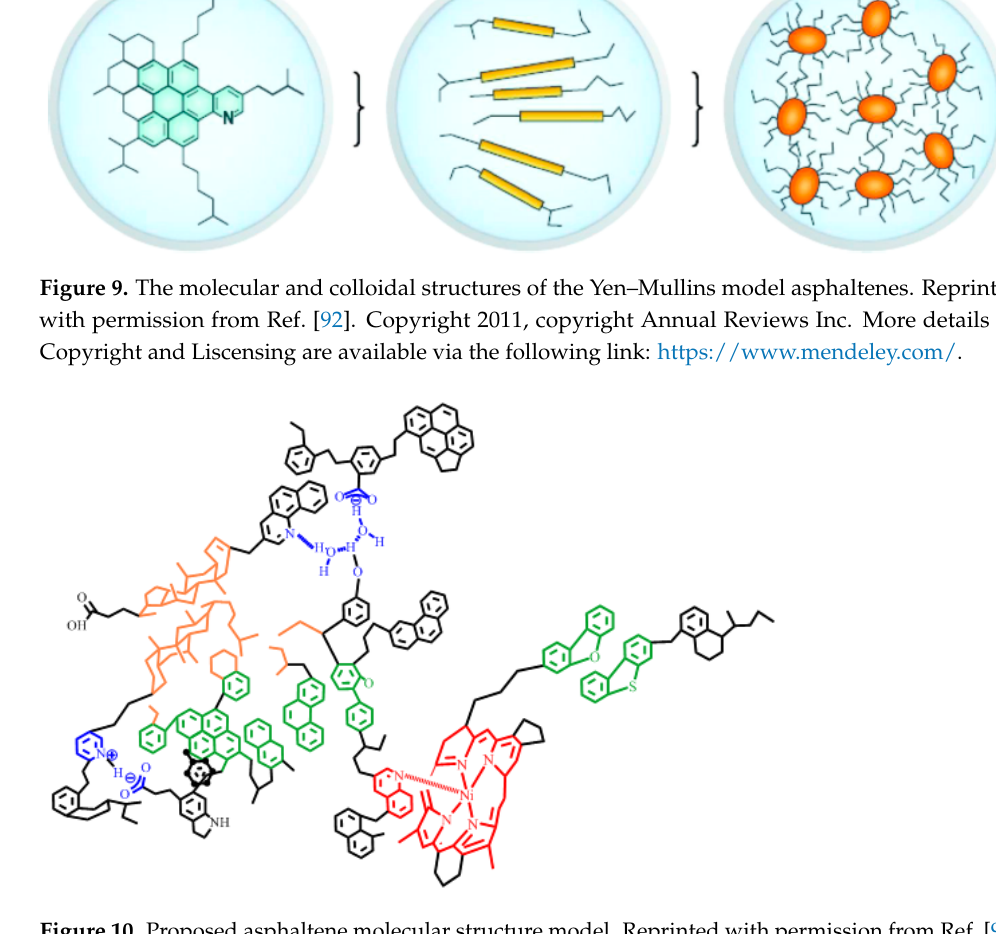
Figure 10. Proposed asphaltene molecular structure model. Reprinted with permission from Ref.